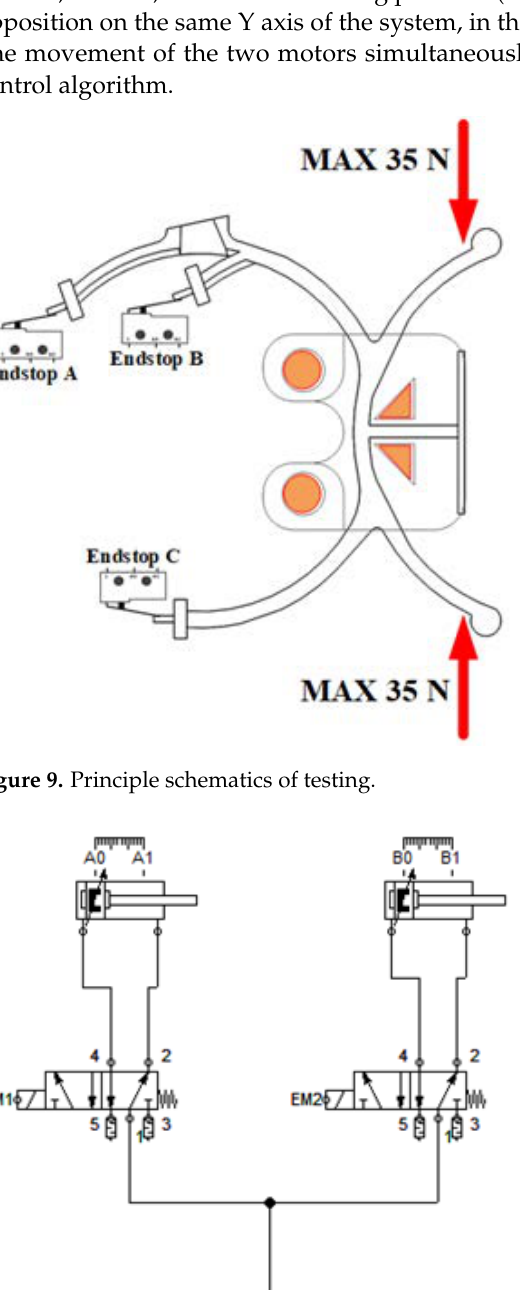
Figure 10. Pneumatic actuation schematics.